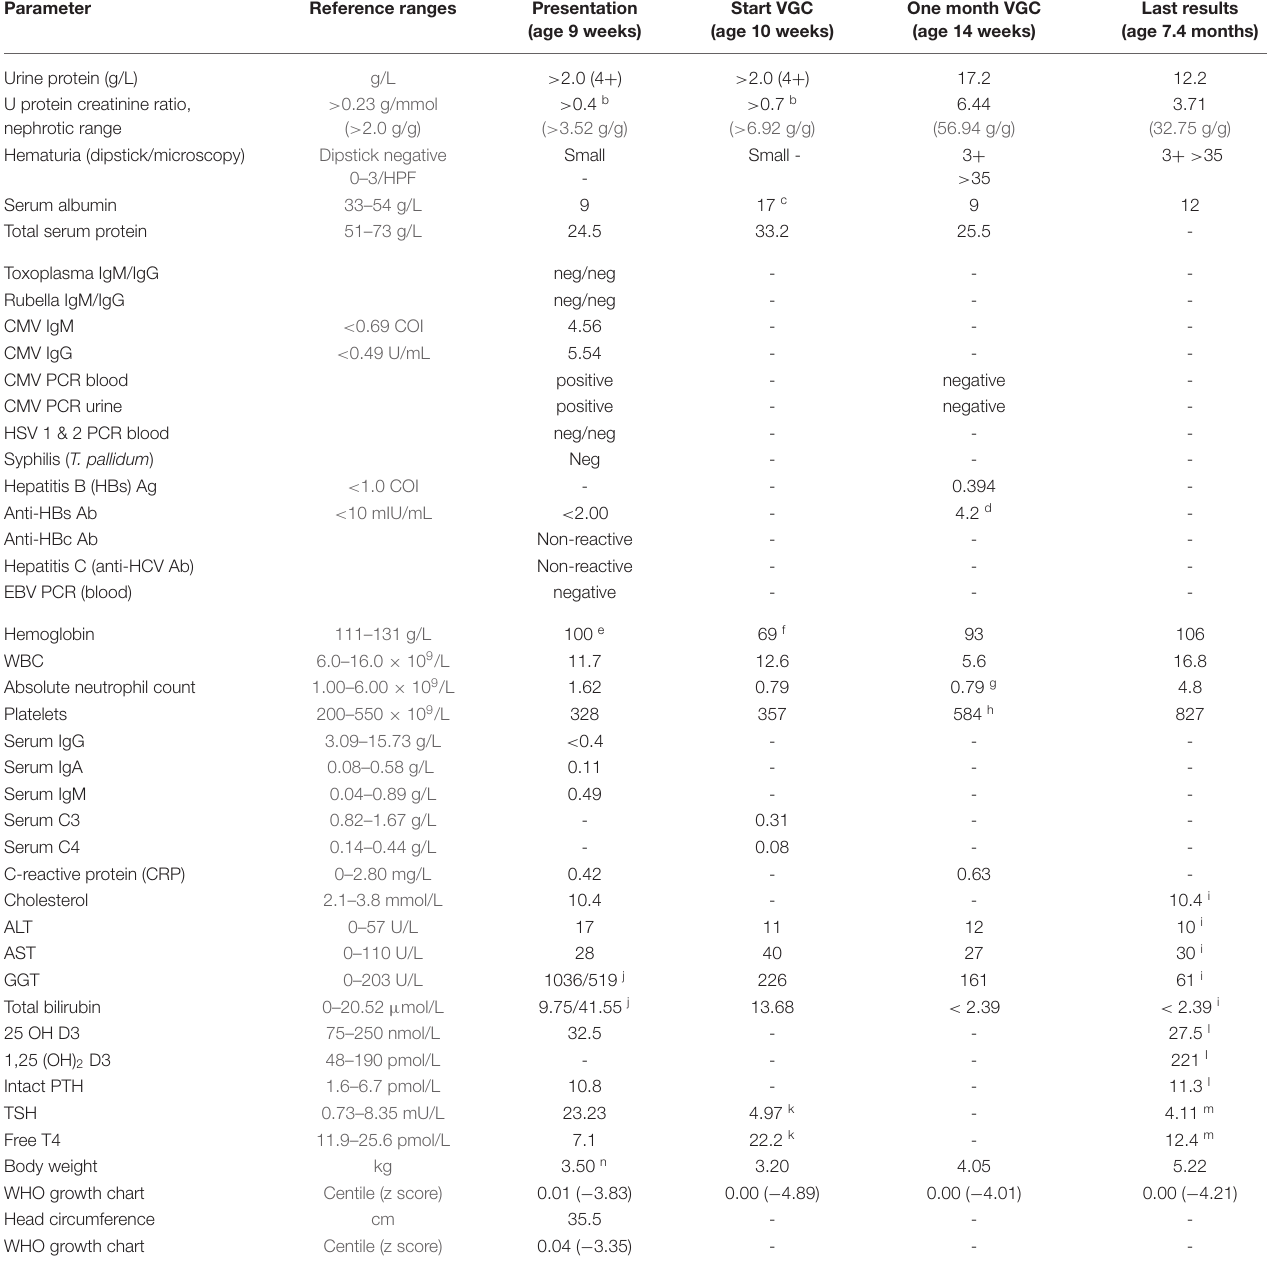
TABLE 1 | Laboratory results during the disease course a